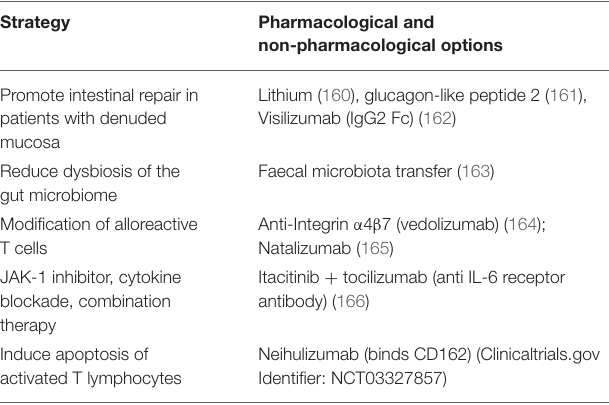
non-pharmacological options